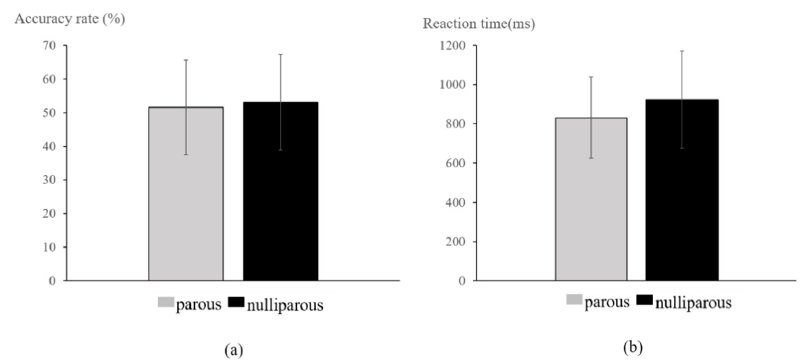
Figure 3. The 3-back task. ( a ) Accuracy rate and ( b ) reaction time.